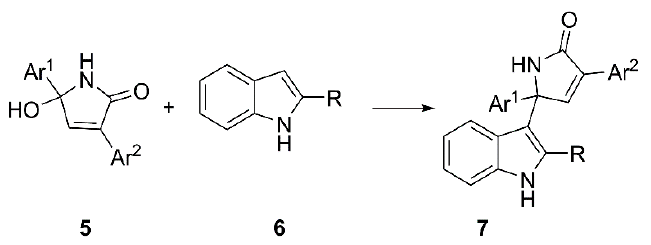
Table 1. Screening of reaction conditions for the reaction of 2-phenylindole 6a with